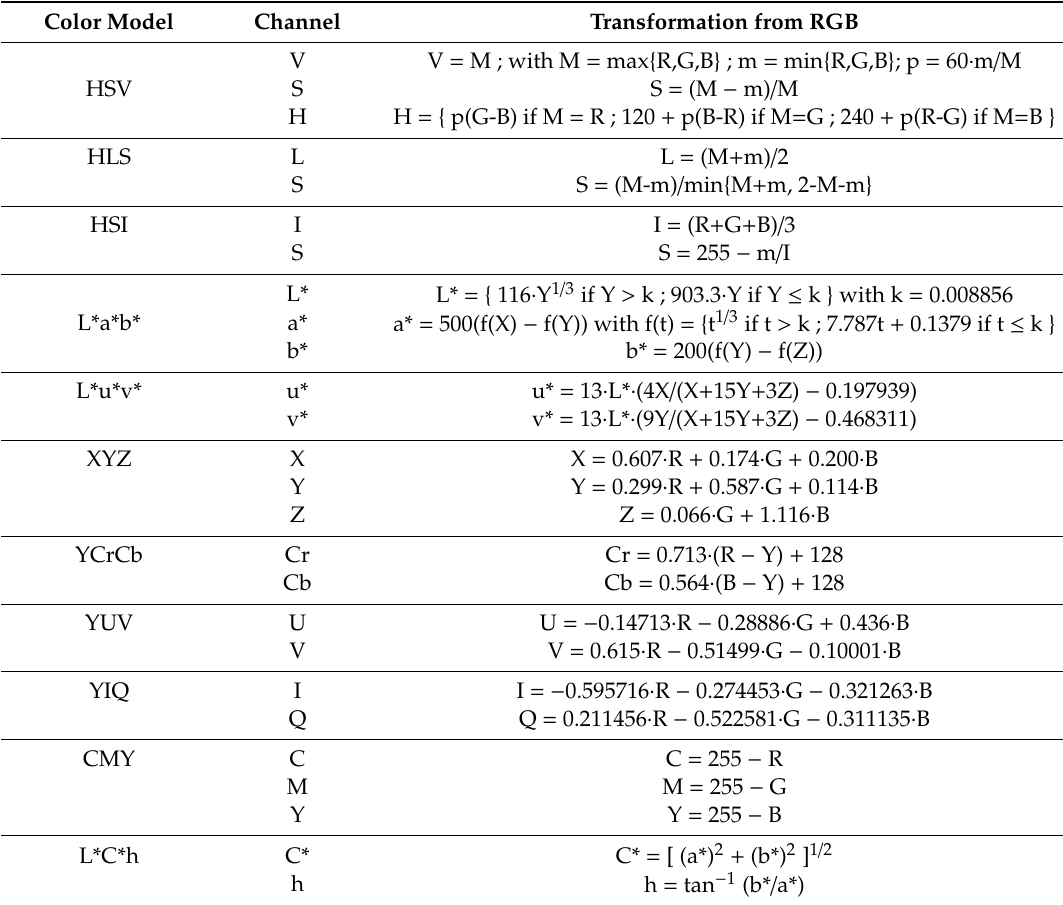
Table 2. Definition of the color models used in the present research. The equations to obtain these channels from the original RGB values are